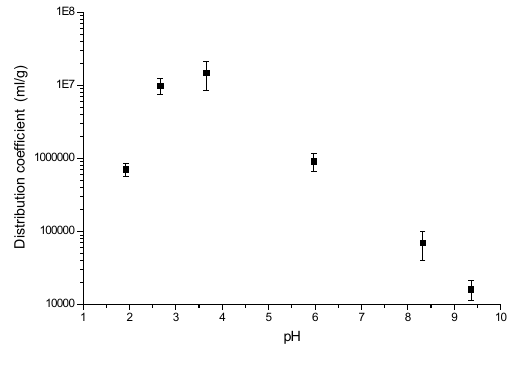
Figure 4. Distribution coefficients (K